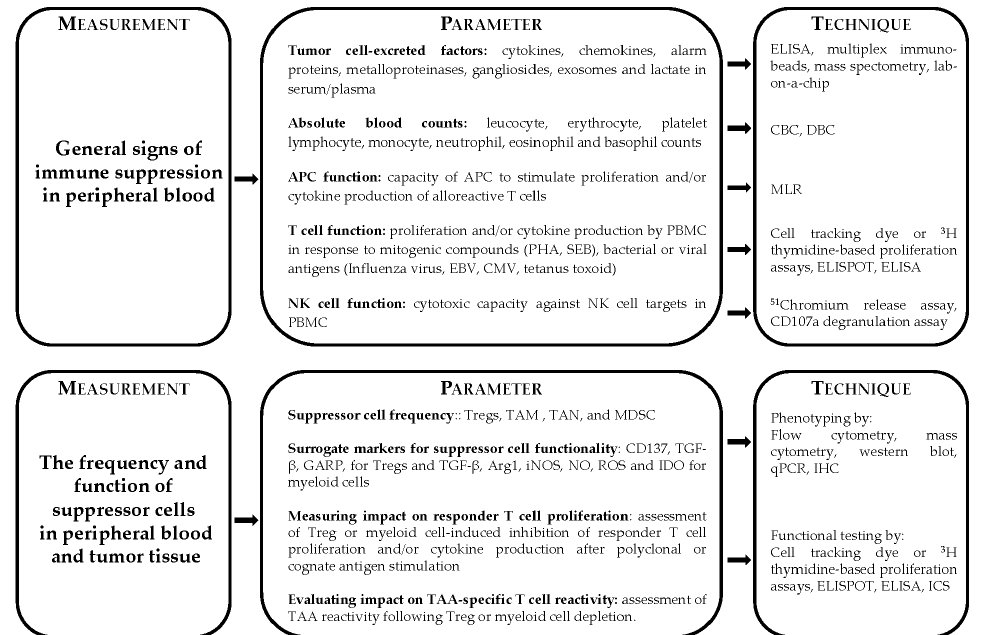
Figure 1. Overview and measurement of the different levels of immune dysfunction present in cancer patients. Immune dysfunction can be analyzed through measuring general signs of immune suppression in the blood (top left) and through measuring the frequency and function of suppressor cells in the blood and tumor tissue (bottom left). The different parameters that can be measured studying these levels of immune dysfunction are depicted (middle), as well as the techniques that can be used (right). Abbreviations used: APC: antigen-presenting cell; Arg1: arginase 1; CBC: complete blood count; CMV: cytomegalovirus; DBC: differential blood count; EBV: Epstein-Barr virus; GARP: glycoprotein A repetitions predominant; ICS: intracellular cytokine staining; IDO: indoleamine-2,3-deoxigenase; IHC: immunohistochemistry; iNOS: inducible nitric oxide synthase; MDSC: myeloid-derived suppressor cells; MLR: mixed lymphocyte reaction; NK: natural killer; NO: nitric oxide; PBMC: peripheral blood mononuclear cells; PHA: phytohemagglutinin; qPCR: quantitative polymerase chain reaction; ROS: reactive oxygen species; SEB: staphylococcal enterotoxin B; TAA: tumor-associated antigen; TAM: tumor-associated macrophages; TAN: tumor-associated neutrophils; TGF- β : transforming growth factor receptor- β ; Treg: regulatory T cells.